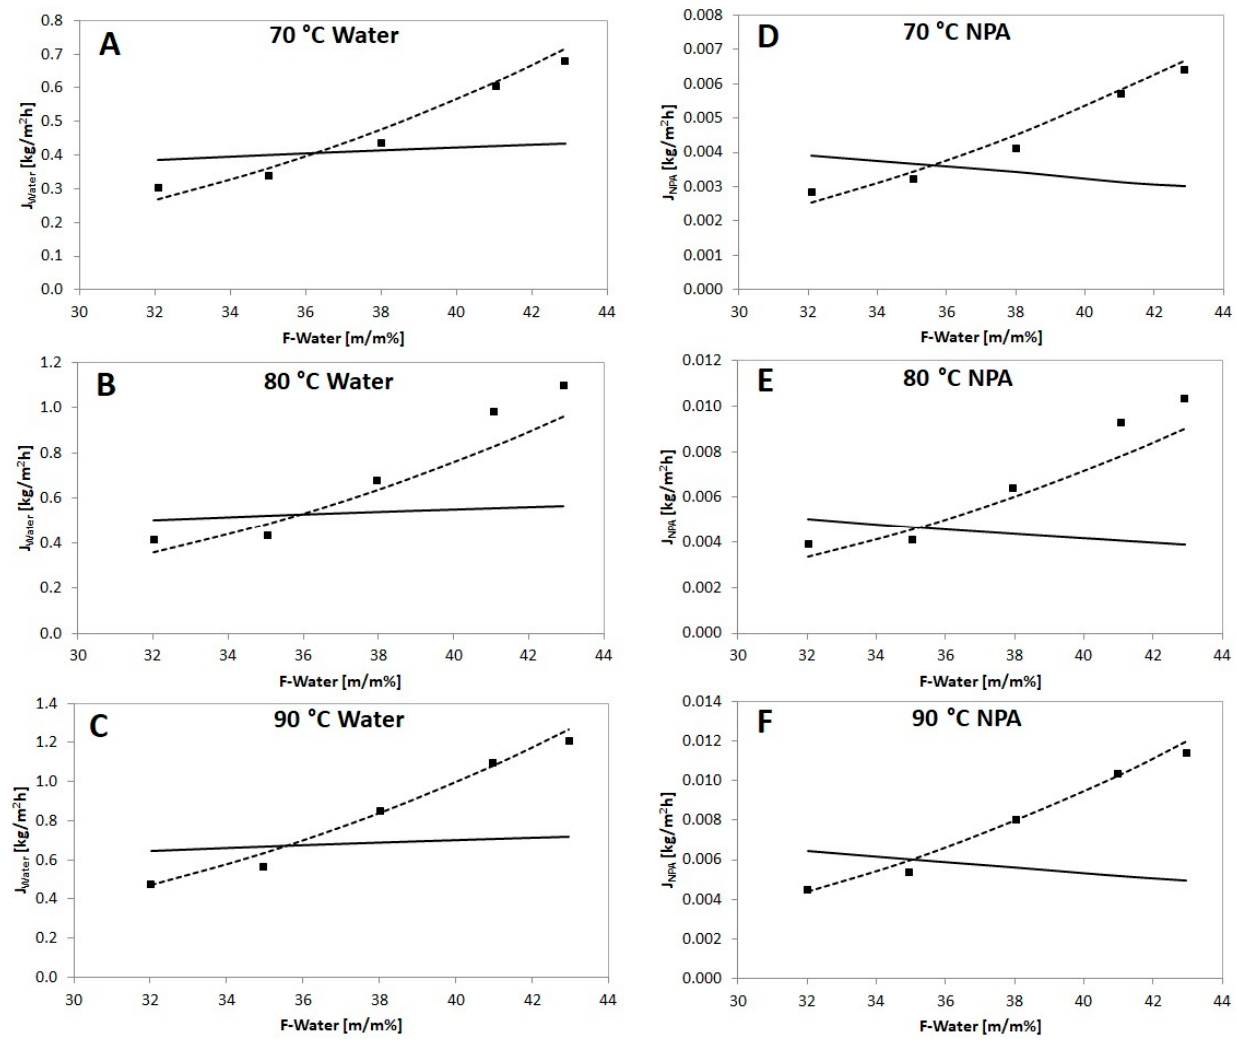
Figure 6 . Experimental water and n-propanol fluxes ( ) compared to calculated partial fluxes with Model I ( ) and Model II ( ) in a function of feed water concentration with PERVAP™ 1201 membrane.